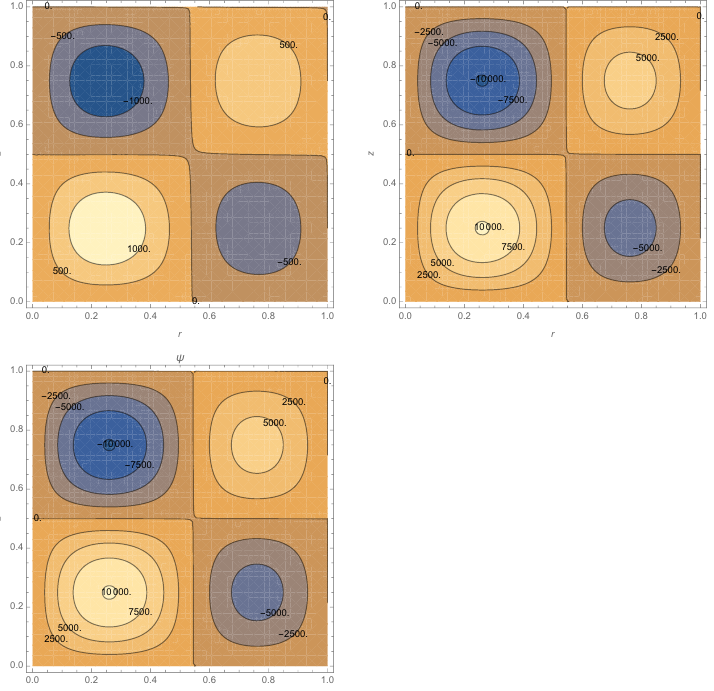
Figure 8. Transition of ψ around the resonance value λ = 9.4179 and α = 0.001: λ = 9.3 ( upper left panel ), 9.4 ( upper right panel ), 9.5 ( bottom panel ). See text for